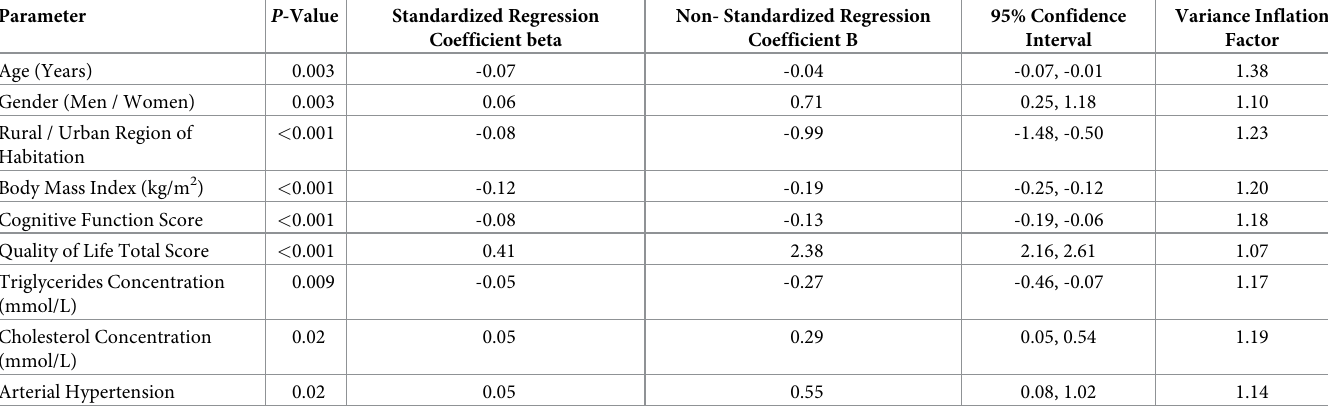
Table 2. Associations (multivariate analysis) between the self-rated depression score and systemic variables in the Beijing Eye